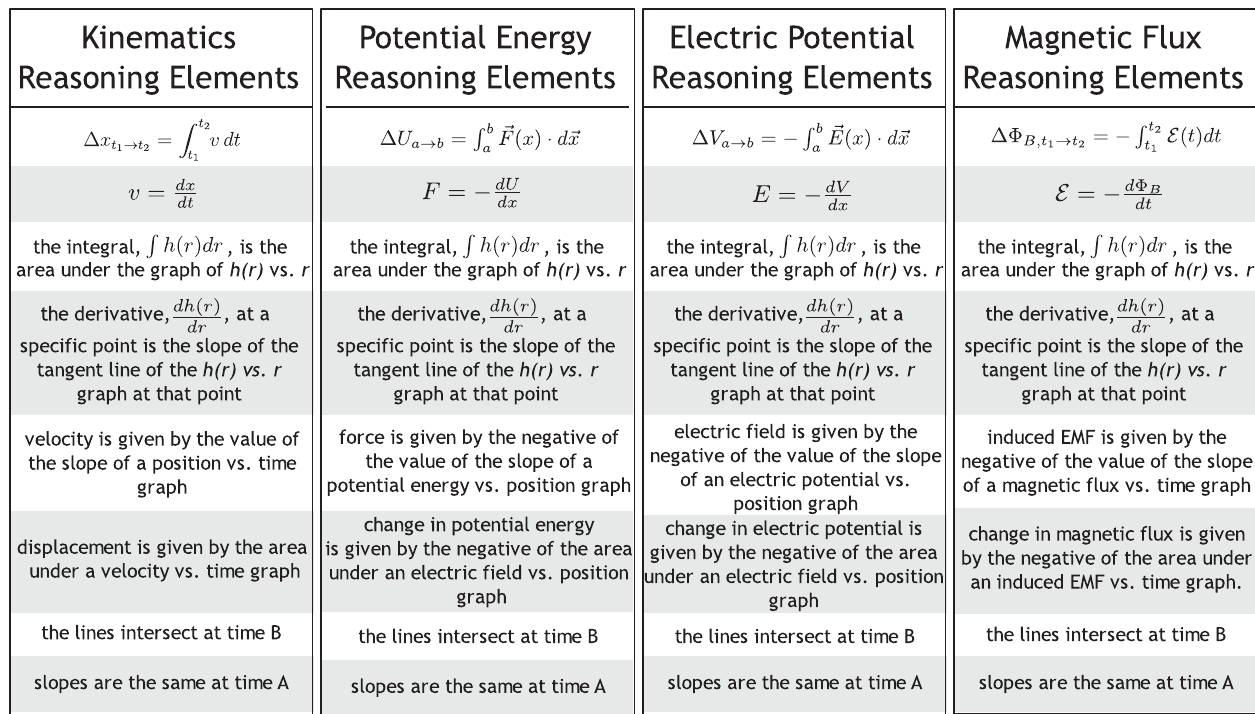
FIG. 8. List of reasoning elements provided for each of the four isomorphic graph